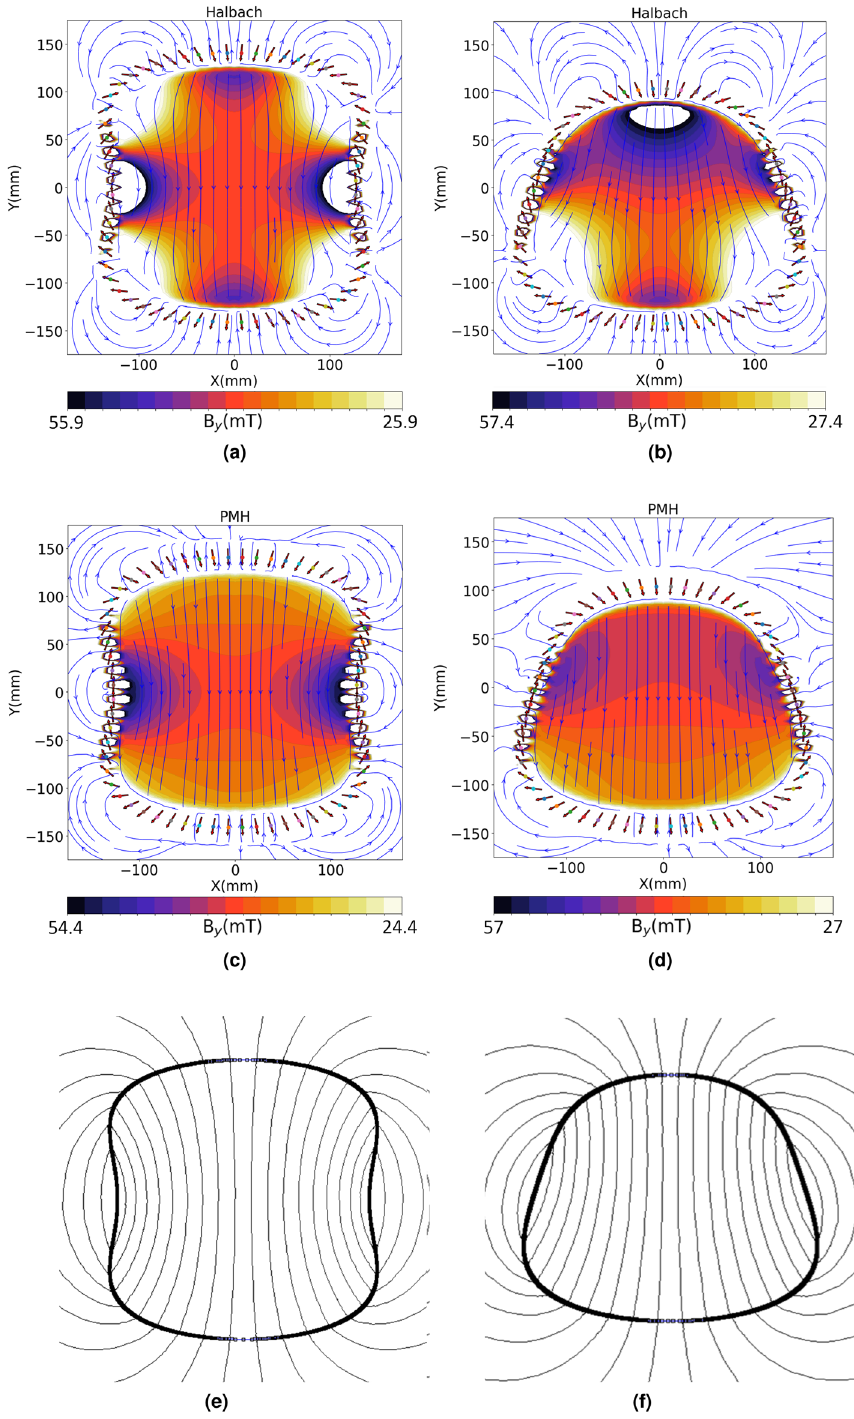
Figure 6. Magnetic field profiles when using ( a ) Halbach’s 2 θ , ( c ) PMH rotation rule and the ( e ) the corresponding VPM for the arbitrarily shaped magnet of a non-circular cross-section of the following form: ax 2 − by 2 + cy 4 = d . This magnet has symmetry in the x- and y- directions. A second example magnet is also 2 − by + cy 4 = d simulated with the following form: ax , where the y-symmetry is lost. The field profiles are presented for ( b ) Halbach and ( d ) PMH rotation rules. The corresponding VPM is shown in ( f ). These profiles are for the dominant magnetic field component ( B y ) at the central cross-section of long magnets (length ≈ 1 m) to avoid end effects). The magnetic field lines are also juxtaposed to show the difference between PMH and Halbach situations for the two magnets. The thick arrows mark the position and orientation of the permanents magnets forming the entire magnet